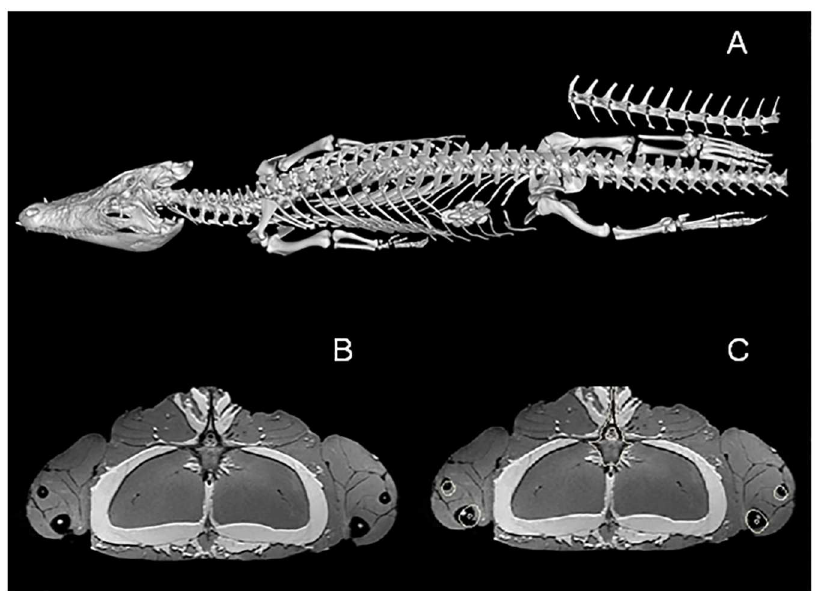
Fig 1. Combining CT and MRI data. CT and MRI data of Crocodylusporosus (XCb Cp4). A = skeleton extracted from CT; B = MRI coronalview of upper hindlimbs;C = same images as B with boneoutlines from CT